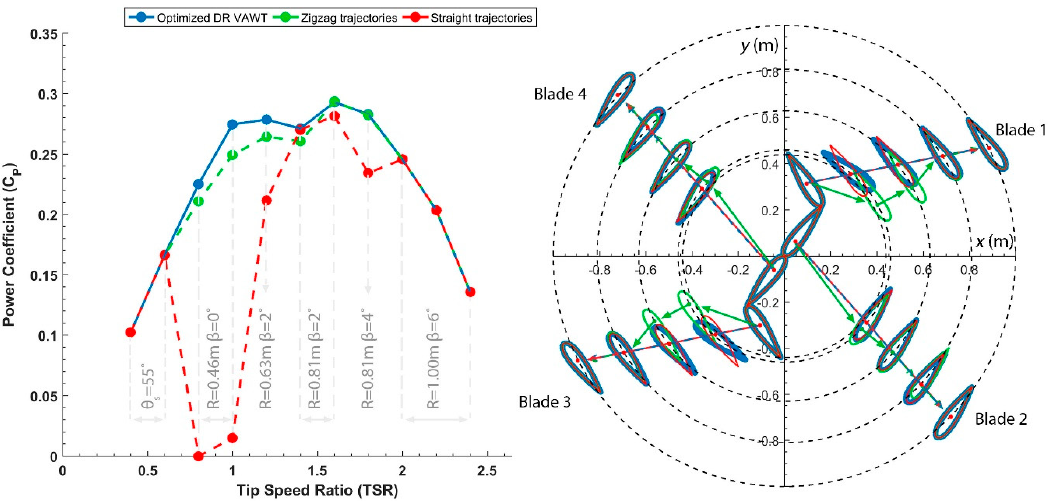
Figure 14. Power coefficient distribution curves for the optimized, zigzag, and straight blades’ trajectories (Re = 145,132).